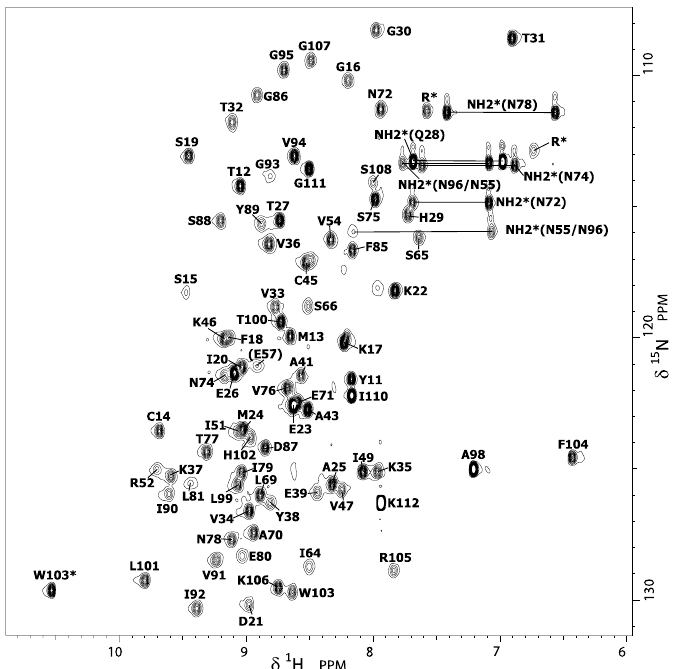
Figure 2. DEN4-ED3 nuclear magnetic resonance (NMR) fingerprint. { 1 H- 15 N} HSQC spectrum (see Materials and Methods section) of DEN4-ED3 at 600 MHz, 10 °C, pH 7.0, recorded on a 1 mM, 15 N-uniformly labeled sample dissolved in a 10 mM Tris buffer (0.5 M guanidine). Cross-peak assignments were indicated using the one-letter amino acid and number code.